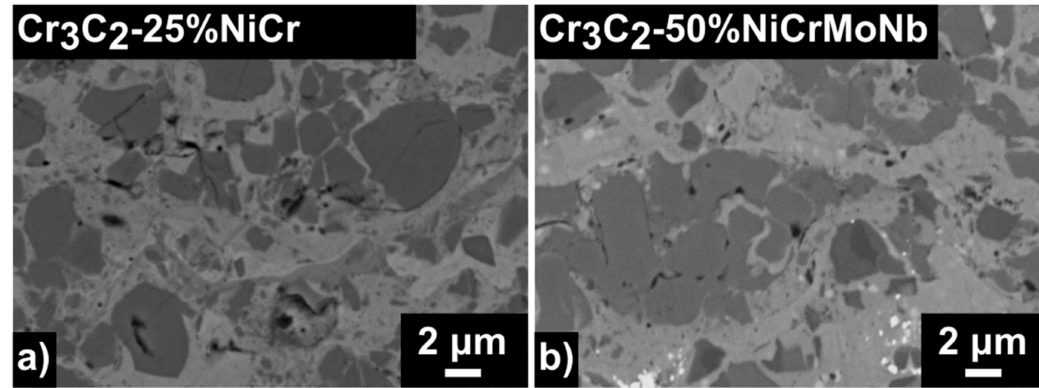
Figure 2. The microstructure of the studied coatings. Comparison of ( a ) the Cr 3 C 2 -25%NiCr coating and ( b )the Cr 3 C 2 -50%NiCrMoNb coating.